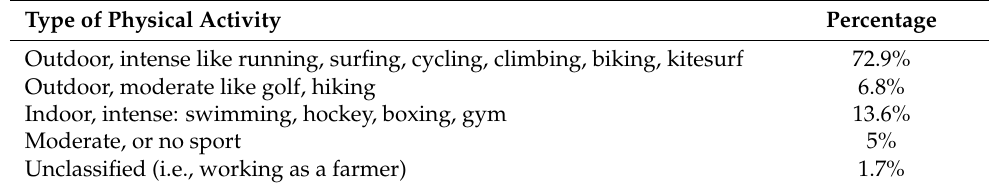
Table 4. Participants’ usual physical activities.